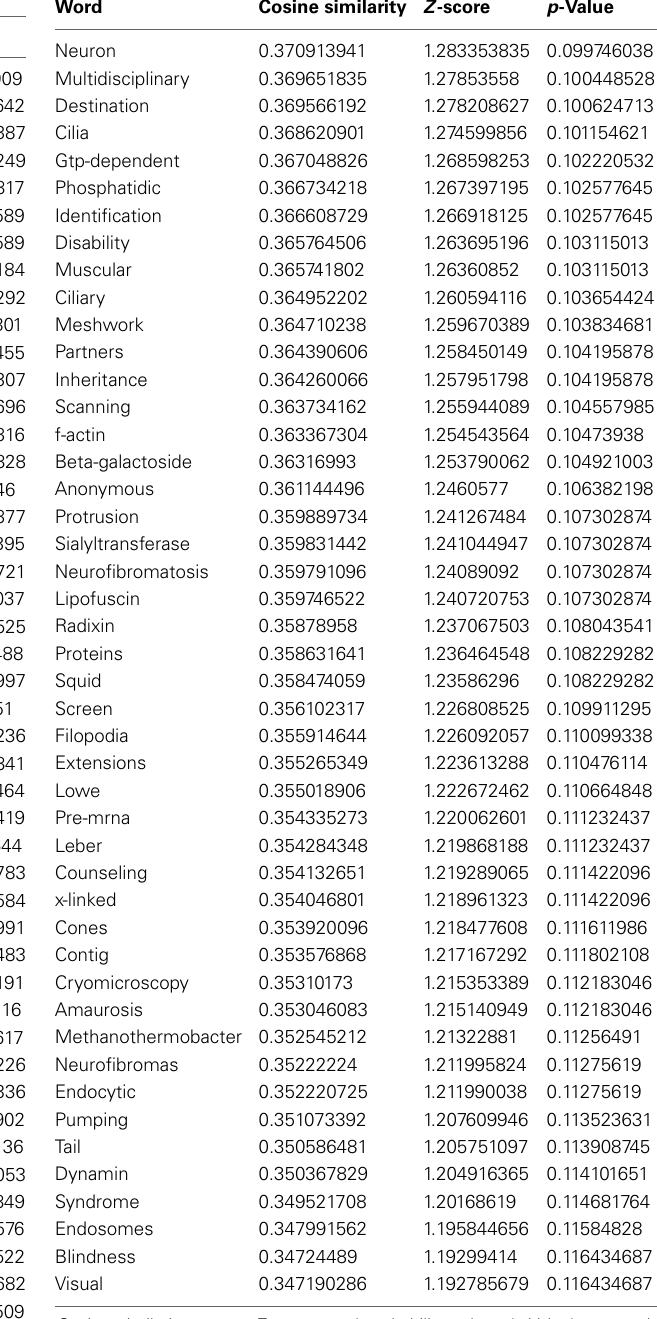
Table 8 | Textrous!- based collective analysis of coherently-regulated BTBR-specific